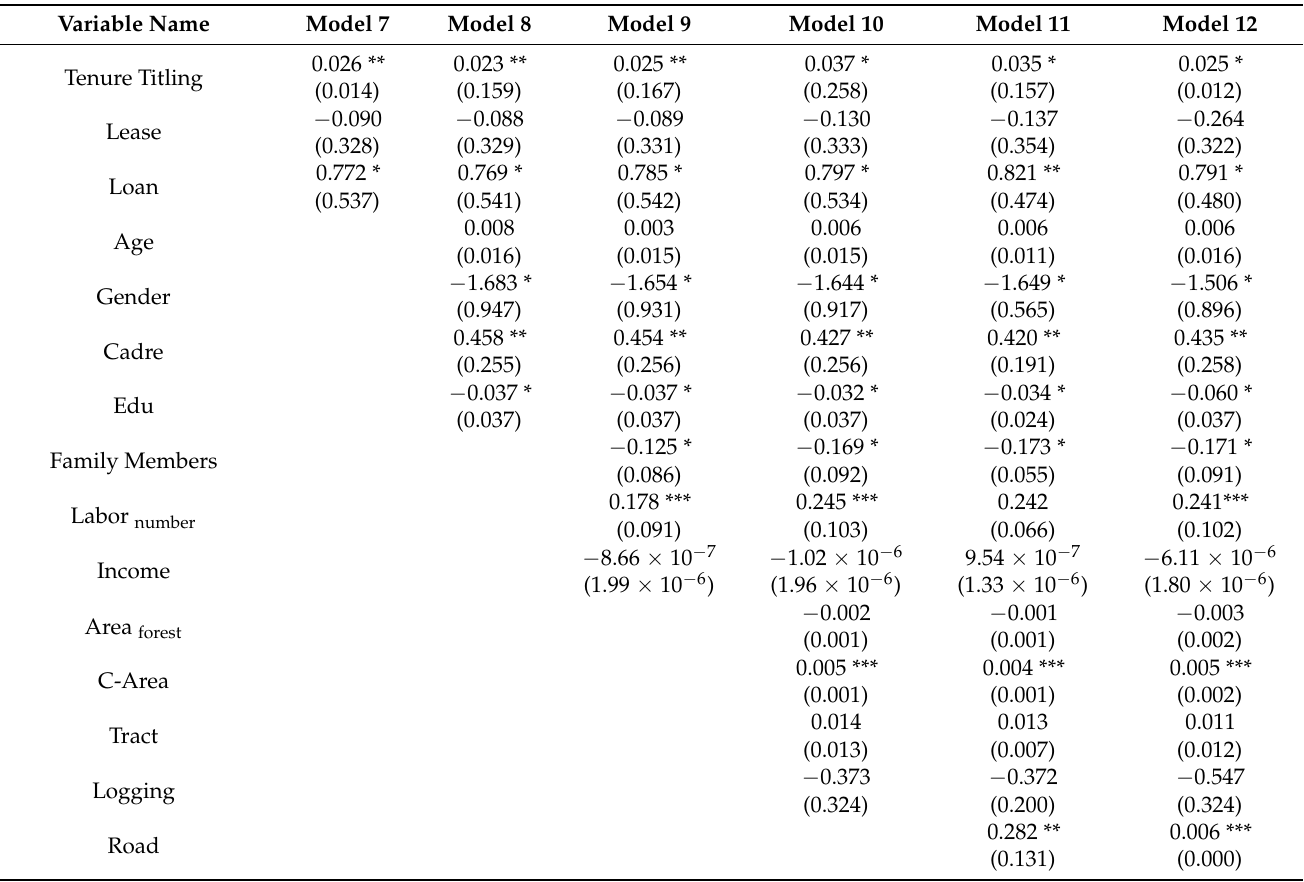
Table 3. Estimated results of household labor